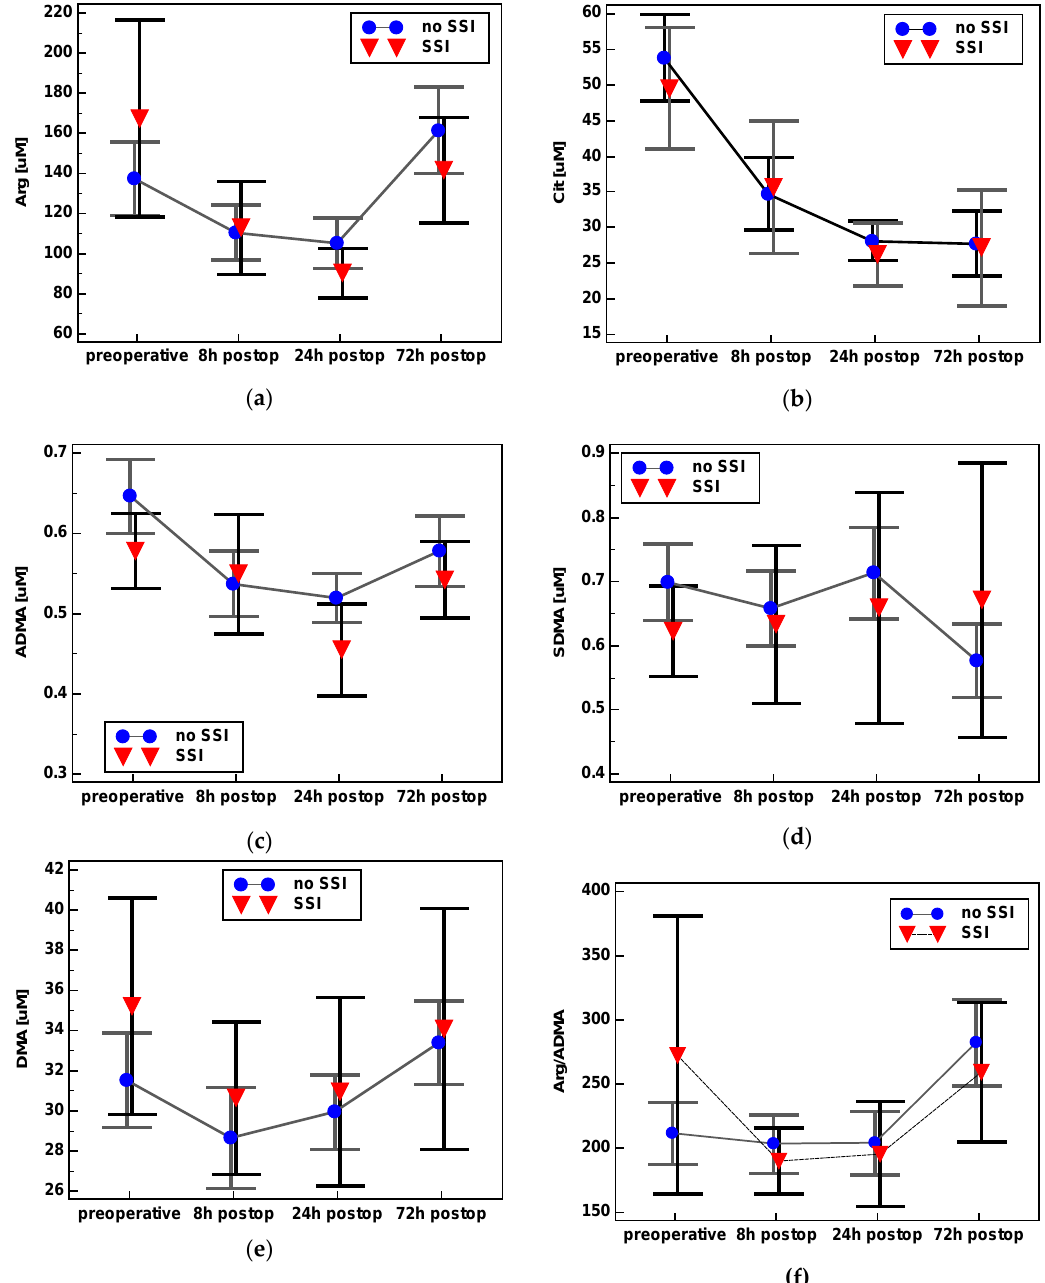
Figure 10. Impact of surgical site infections (SSI) on postoperative dynamics of L-arginine/NO pathway metabolites: ( a ) Arginine—Arg; ( b ) citrulline—Cit; ( c ) asymmetric dimethylarginine—ADMA; ( d ) symmetric dimethylarginine—SDMA; ( e ) dimethylamine—DMA; ( f ) Arg/ADMA. Data presented as means with a 95% confidence interval and analyzed using repeated measures ANOVA. Postop: Postoperative.